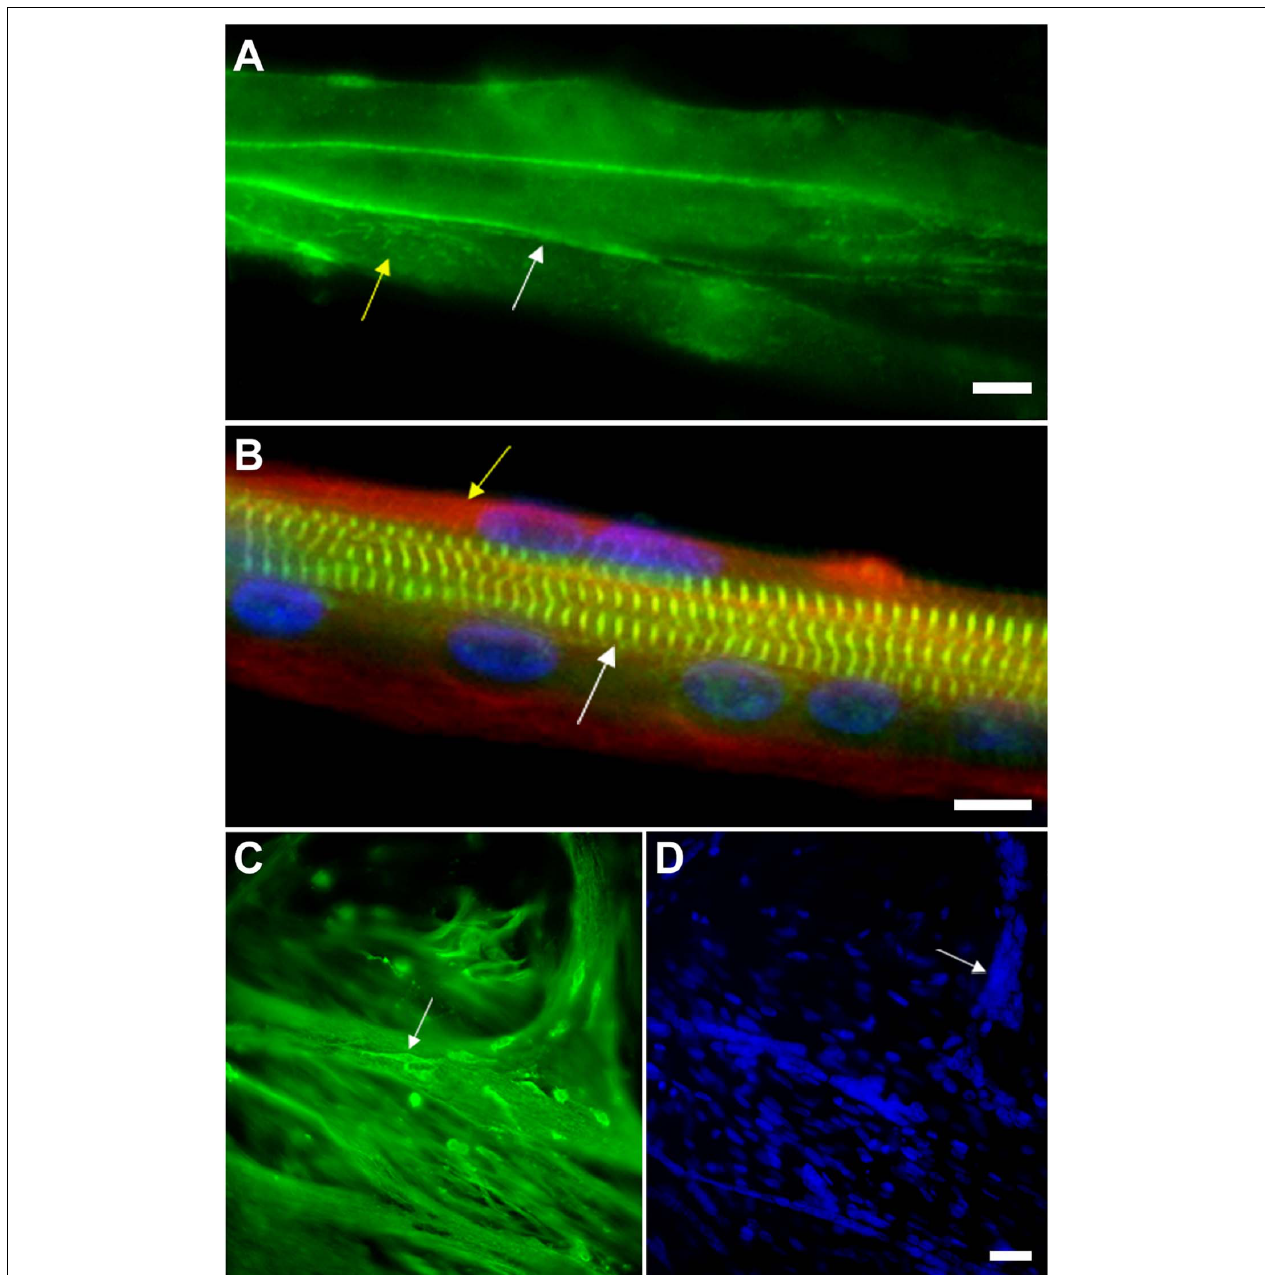
FIGURE 3 | Myoblast adhesion and myotube formation are hallmarks of skeletal myogenesis. (A) Cadherin and beta-catenin accumulate at cell-cell adhesion contacts in pre-fusion chick myoblasts. In chick myogenic cultures 24 h after cell plating, primary fusion (myoblast-myoblast fusion) can be observed as an intense immunolabeling of beta-catenin (green, white arrow in A ) in continuous lines at cell-cell contacts. Note that beta-catenin is also present in a dot-like pattern in the whole sarcolemma (green, yellow arrow in A ). Scale bar in (A) = 10 µ m. (B) Myotubes from chick primary skeletal muscle cultures are multinucleated cells that contain highly organized myofibrils. Chick skeletal muscle cells were grown in culture for 72 h and stained with antibodies anti-sarcomeric alpha-actinin (green), anti-desmin (red, yellow arrow in B ) and with the nuclear dye DAPI (blue). Note in the merged image the periodical labeling of alpha-actinin in the Z-bands of myofibrils (white arrow in B ), the presence of desmin filaments at the periphery of the myotube (yellow arrow in B ) and well-aligned nuclei. Scale bar in B = 10 µ m. (C,D) Myoblasts adhere to myotubes in a secondary fusion process. Chick skeletal muscle cells were grown in culture for 72 h and stained with antibodies anti-alpha-tubulin (green, C ) and with the nuclear dye DAPI (blue, D ). Small mononucleated myoblasts (white arrow in C ) can be seen at the top of a multinucleated myotube, which is evidenced by the microtubule staining. DAPI shows the presence of a high number of nuclei in each chick myotube cell (blue, D ). Image (A) shows a 24-h primary myogenic culture, where most of the myoblasts are undergoing primary myoblast fusion (myoblast-myoblast fusion), while image (C) shows a 72-h primary myogenic culture, where secondary myoblast fusion (myoblast-myotube fusion) is frequently observed. Scale bar in (D) = 20 µ m.